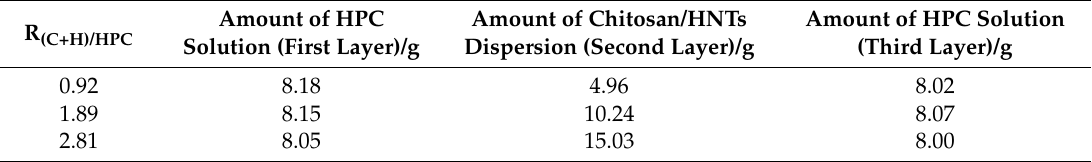
Table 2. The composition of the nanocomposites and the corresponding amounts of hydroxypropyl cellulose (HPC) solutions and chitosan/halloysite nanotubes (HNTs) dispersions used in the sequential